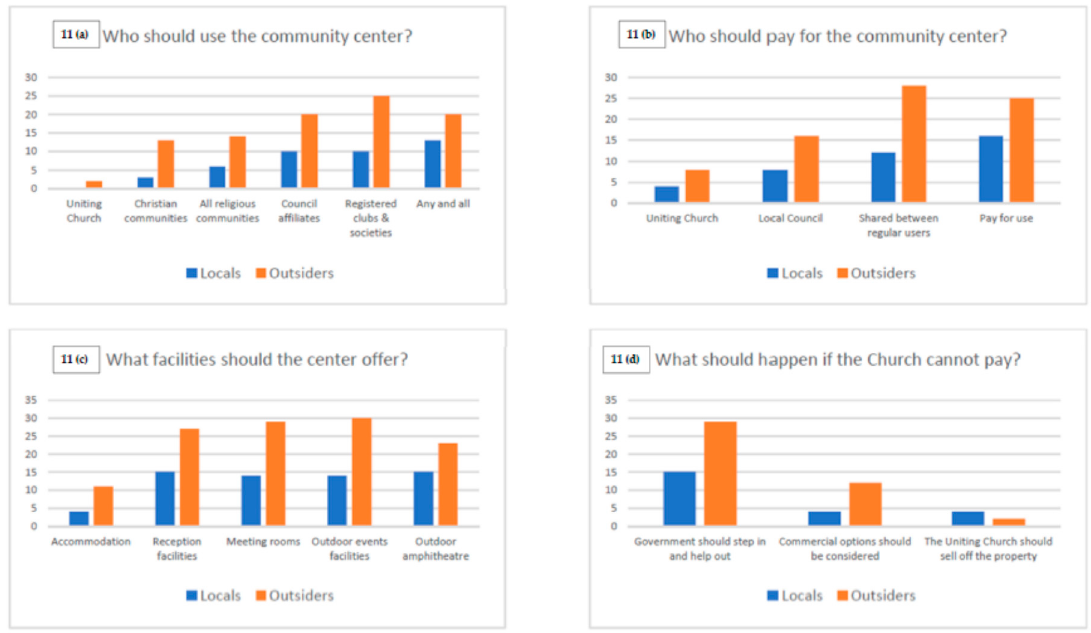
Figure 11. Statistical response summaries for the 64 returned questionnaire surveys.